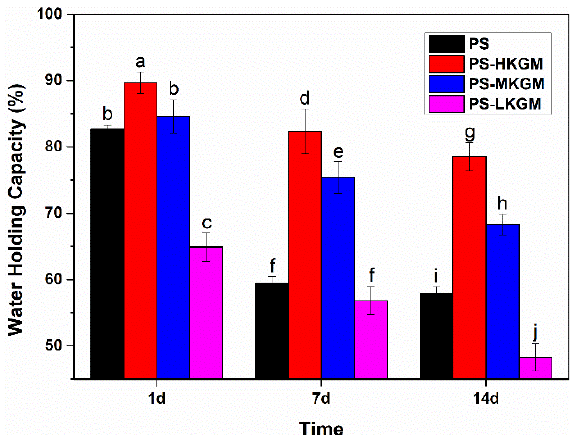
Figure 4. Water holding capacity of PS — KGM mixtures at different storage times (HKGM, MKGM and LKGM represented KGM with high, medium and low molecular weight, respectively. PS represents pea starch. Different letters indicate significant differences at the p < 0.05 level) .